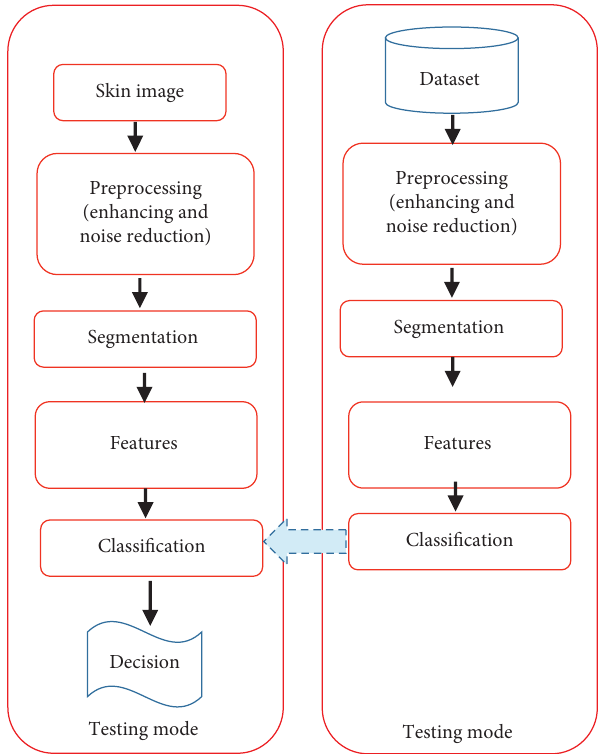
Figure 4: The general overview of the proposed system including main necessary